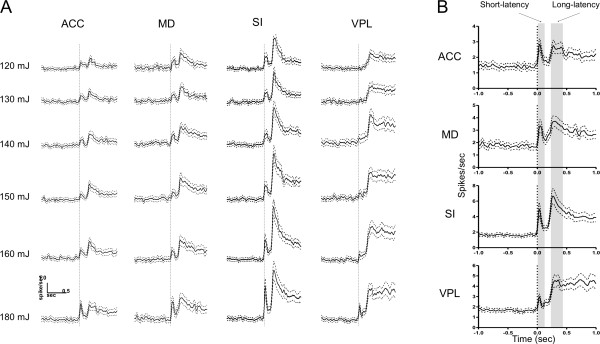
The averaged single-unit response to laser stimulation for each brain region of interest at differing stimulation intensity levels (A) and averaged for all intensity levels (B). (A) Mean firing rate increased with stimulus intensity (120-180 mJ) for all the recorded regions (ACC, MD, SI, and VPL). Each panel represents the averaged firing rate of neurons around the time of laser stimulation (1.0 s pre- to 1.0 s post-stimulus). The dashed lines indicate 99% confidence limits. (B) When the single-unit responses are pooled across all the intensity levels (120-180 mJ), a double-peak response can be seen in all the recorded regions with a short-latency peak of less than 100 ms and a long-latency of 300-500 ms.